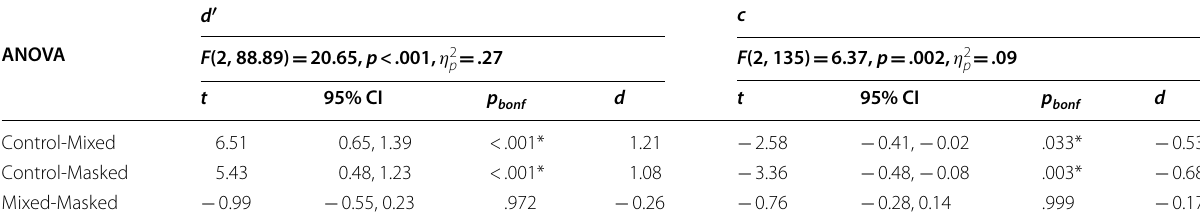
Table 2 Separate ANOVA and post hoc analyses for measures of human performance ( d ′ , c ) on the GFMT d ′